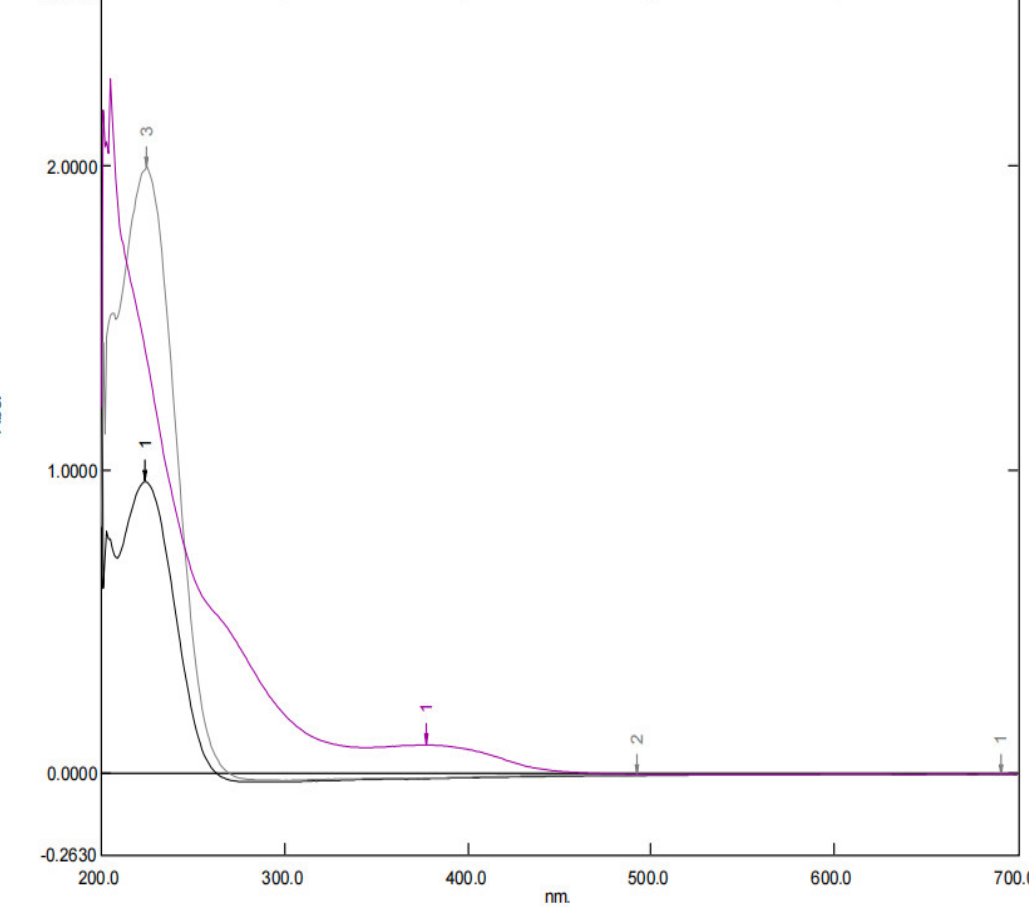
Figure 12. Spectrum UV-Vis of andrographolide extract (purple), isolate (grey), and standard (black).